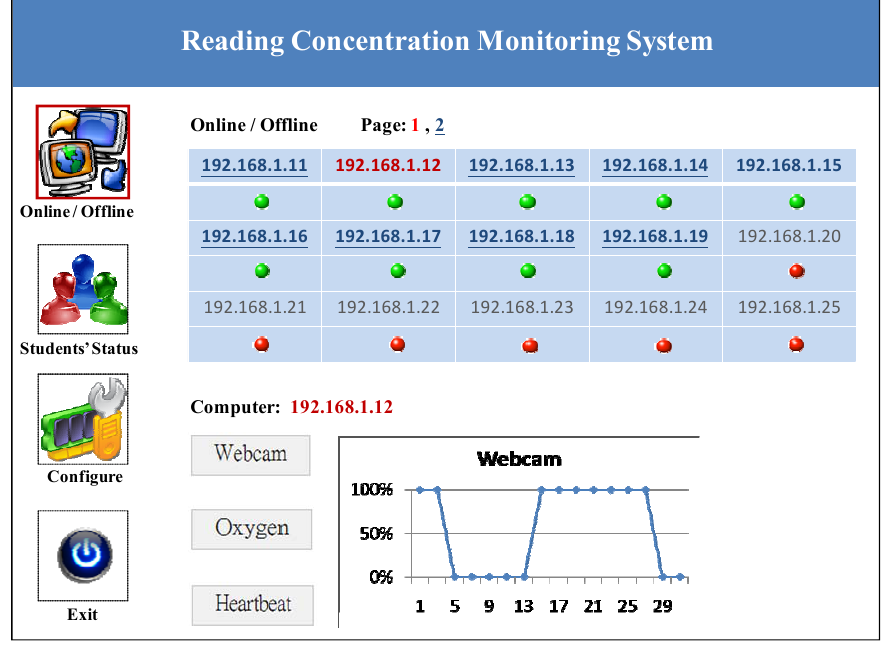
Figure 7. Reading status of an individual